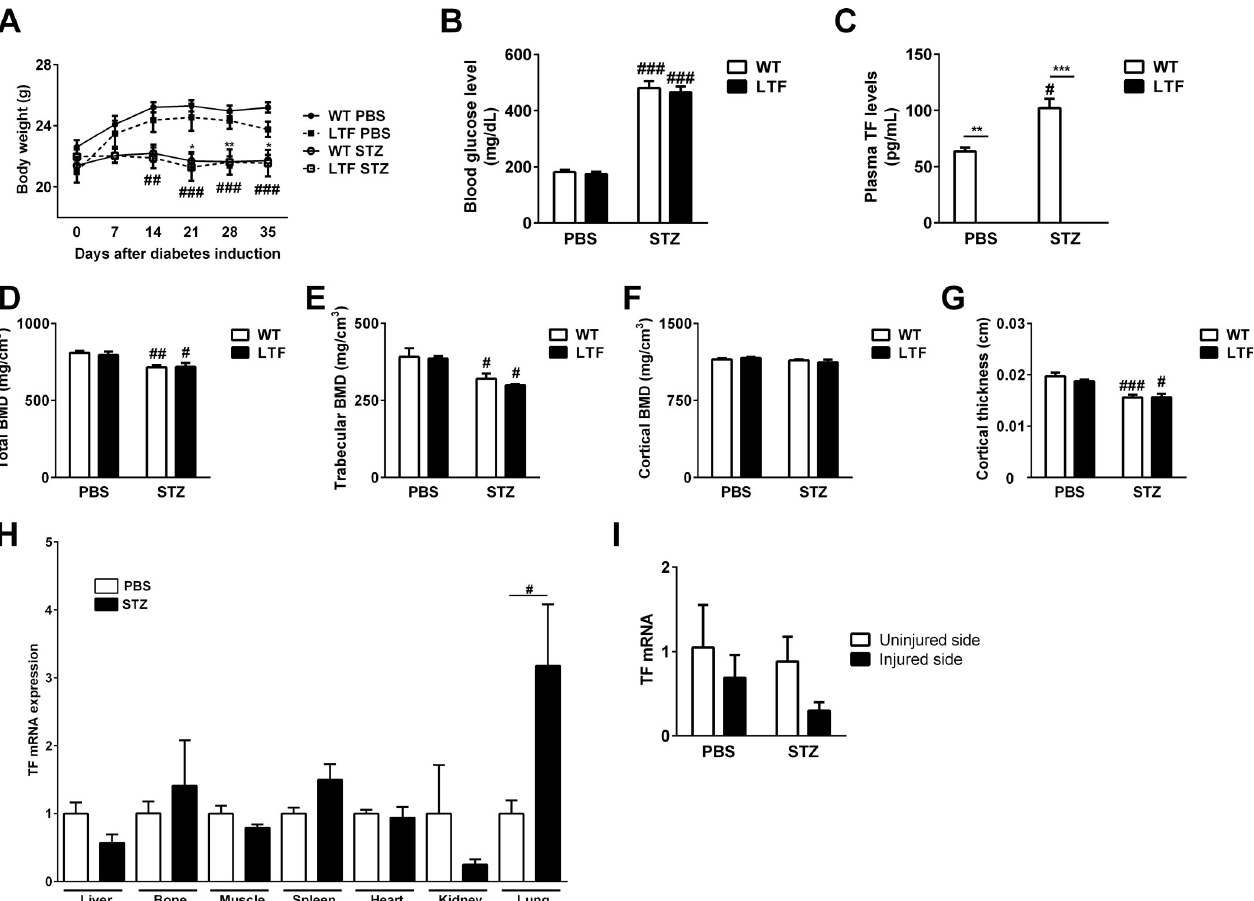
Fig 1. Effects of TF levels on the induction of diabetes and diabetic osteoporosis. (A) Body weight change after the induction of diabetes by a streptozotocin (STZ) injection. Data on PBS (Control: ● )- or STZ (STZ: ○ )-treated WT mice and PBS (Control: ■ )- or STZ (STZ: □ )-treated LTF mice are shown. ## P < 0.01 and ### P < 0.001, significantly different from PBS-treated WT control mice; � P < 0.05 and �� P < 0.01, significantly different from PBS-treated LTF control mice (n � 6 in each group of mice). (B) Blood glucose levels in PBS- or STZ-treated WT and LTF mice. ### P < 0.001, significantly different from PBS-treated WT control mice. (n � 6 in each group of mice). (C) Plasma TF levels in PBS- or STZ-treated WT and LTF mice. � P < 0.05. (n � 6 in each group of mice). (D-G) Total bone mineral density (BMD) (D), trabecular BMD (E), cortical BMD (F), and cortical thickness (G) in the tibia of WT and LTF mice treated with or without STZ, as assessed by qCT 3 weeks after the induction of diabetes. Data represent the mean ± SEM of 6 mice. # P < 0.05 and ### P < 0.001, significantly different from PBS-treated control mice. (H) TF mRNA levels in the liver, bone, muscle, spleen, heart, kidneys, and lungs of PBS (white bar)- or STZ (black bar)-treated WT mice. Samples were harvested 3 weeks after the induction of diabetes. Results are shown relative to β -actin mRNA values (mean ± SEM). # P < 0.05 (n = 4–7 in each group). (I) TF mRNA levels in the femoral bone at uninjured and injured sides in WT mice treated with or without STZ (n = 7 in each group of